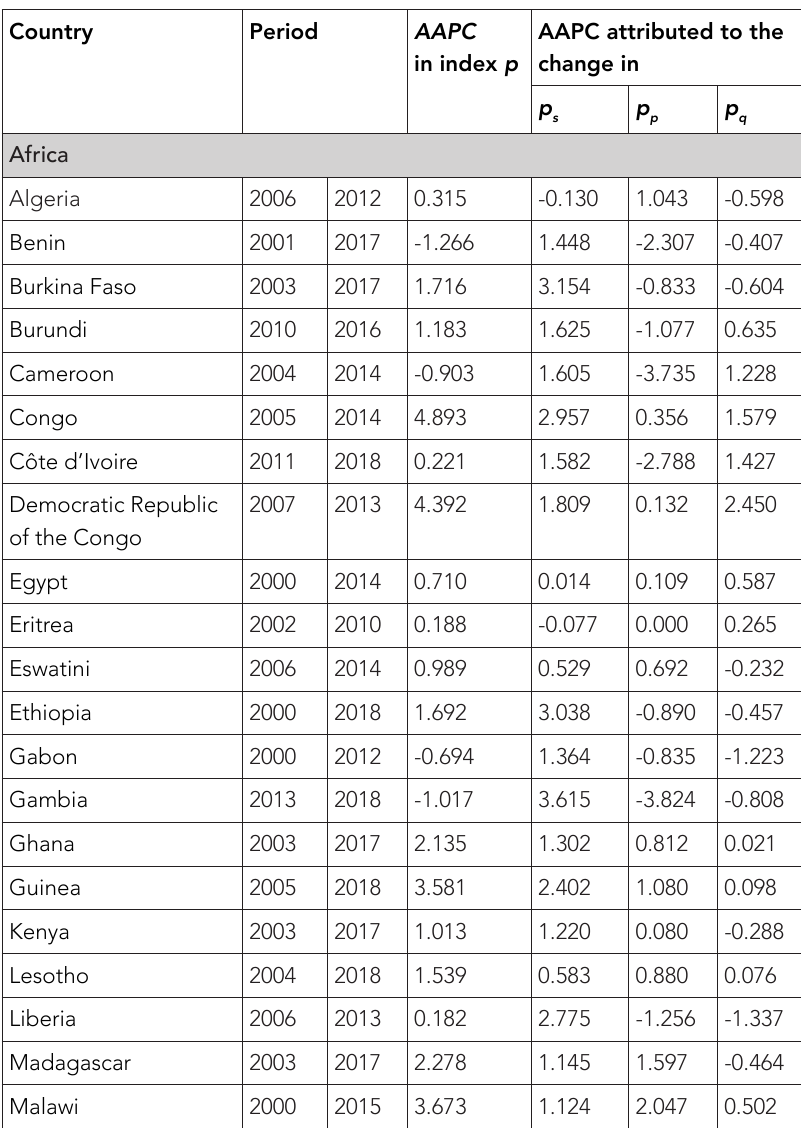
Appendix Table 2: Decomposition of AAPC in the Index